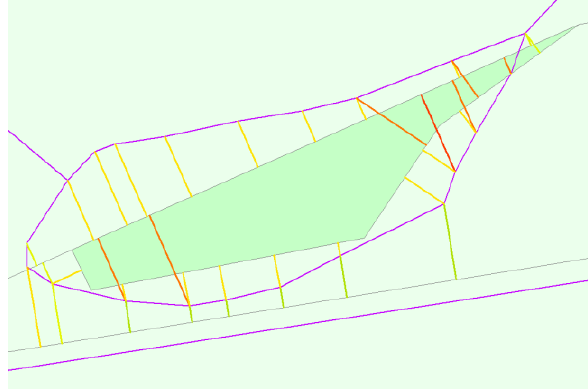
Figure 14. ALKIS (black) and ATKIS (purple) data overlay for grove area. Links with similarity indication (coloured lines) The fourth test area is giving an example for a false positive line segment matching (see Figure 14). In the semantic correspondence matrix, a link between a grove (green) and an agricultural patch (light green) has a higher probability than a